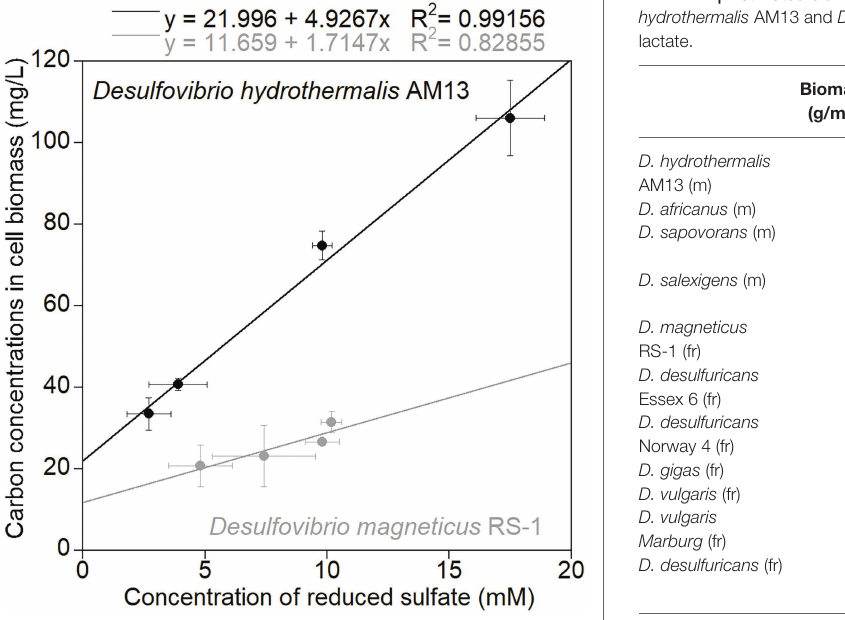
FIGURE 1 | Average carbon concentrations in cell biomass (mg/L) measured in cell pellets recovered from cultures grown without Fe(II), as a function of average concentrations of reduced sulfate (mM). Black circles are data for marine strain Desulfovibrio hydrothermalis AM13, and gray circles are data for freshwater Desulfovibrio magneticus RS-1. Error bars represent ±one standard deviation. The slope of the linear regressions gives the amount of biomass carbon (g) produced per mol sulfate reduced as: 4.9 g biomass carbon/mol sulfate for Dh AM13 and 1.7 g biomass carbon/mol sulfate for Dm RS-1.